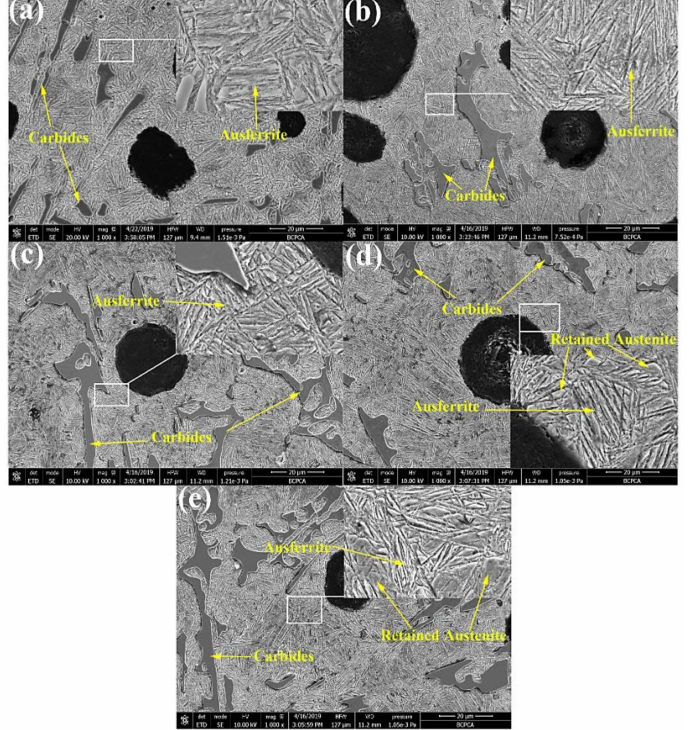
Figure 12. Morphological structures of carbidic austempered ductile iron with varying Cu percent- ages: ( a ) 0 wt.% Cu, ( b ) 0.5 wt.% Cu, ( c ) 1 wt.% Cu, ( d ) 1.5 wt.% Cu, and ( e ) 2 wt.% Cu